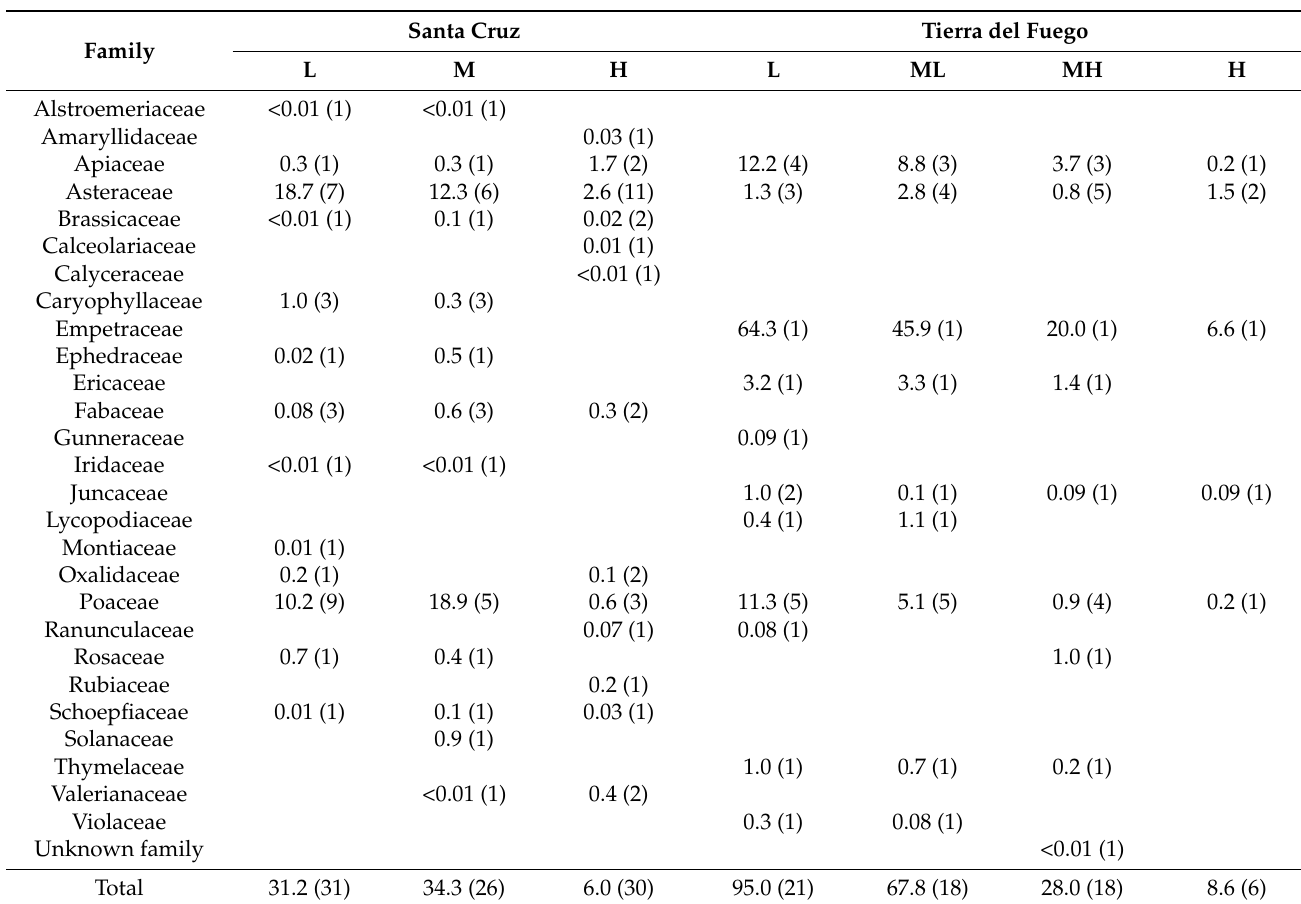
Table 1. Average cover (%) and total richness (number of species in parentheses) of families of alpine vascular plants, including the entire survey information (baseline and re-sampling data), in two South Patagonia mountain sites, immersed in grassland (Santa Cruz) or forest (Tierra del Fuego) landscapes. The summits are classified by their maximum elevation (L = low, M = medium, ML = medium-low, MH = medium-high, H =